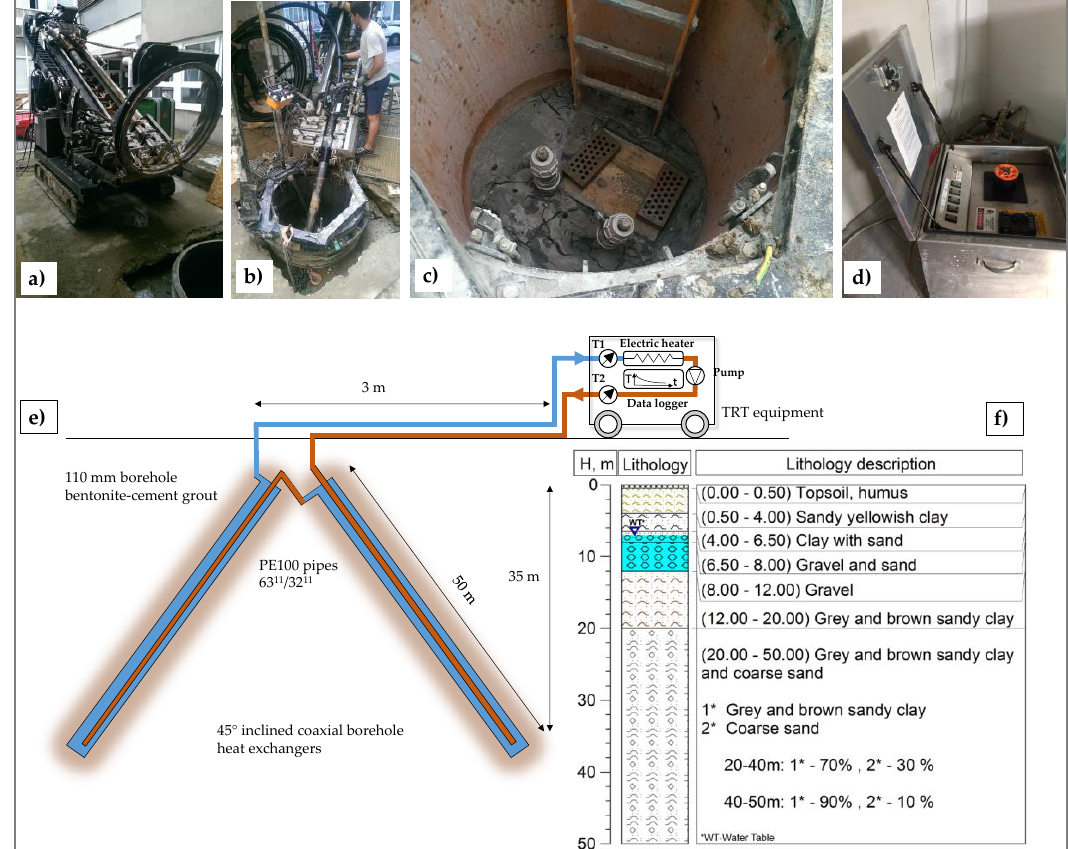
Figure 5. Test site setup: ( a ) Borehole drilling equipment; ( b ) Inserting coaxial borehole heat exchanger; ( c ) Heat exchanger shaft; ( d ) TRT equipment; ( e ) Schematics of testing site; ( f ) Lithology description.